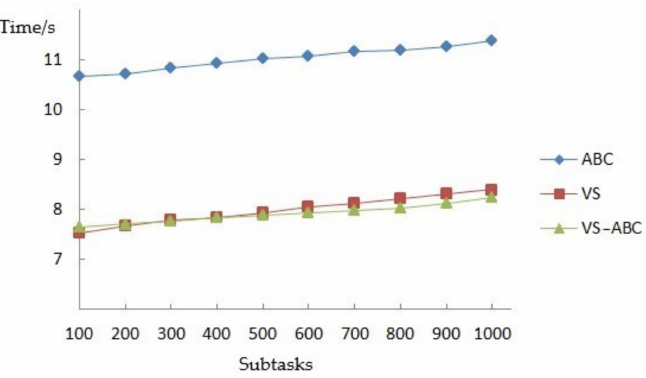
Figure 9. The trend of three algorithms’ running time ( n = 100, J = 100–1000).